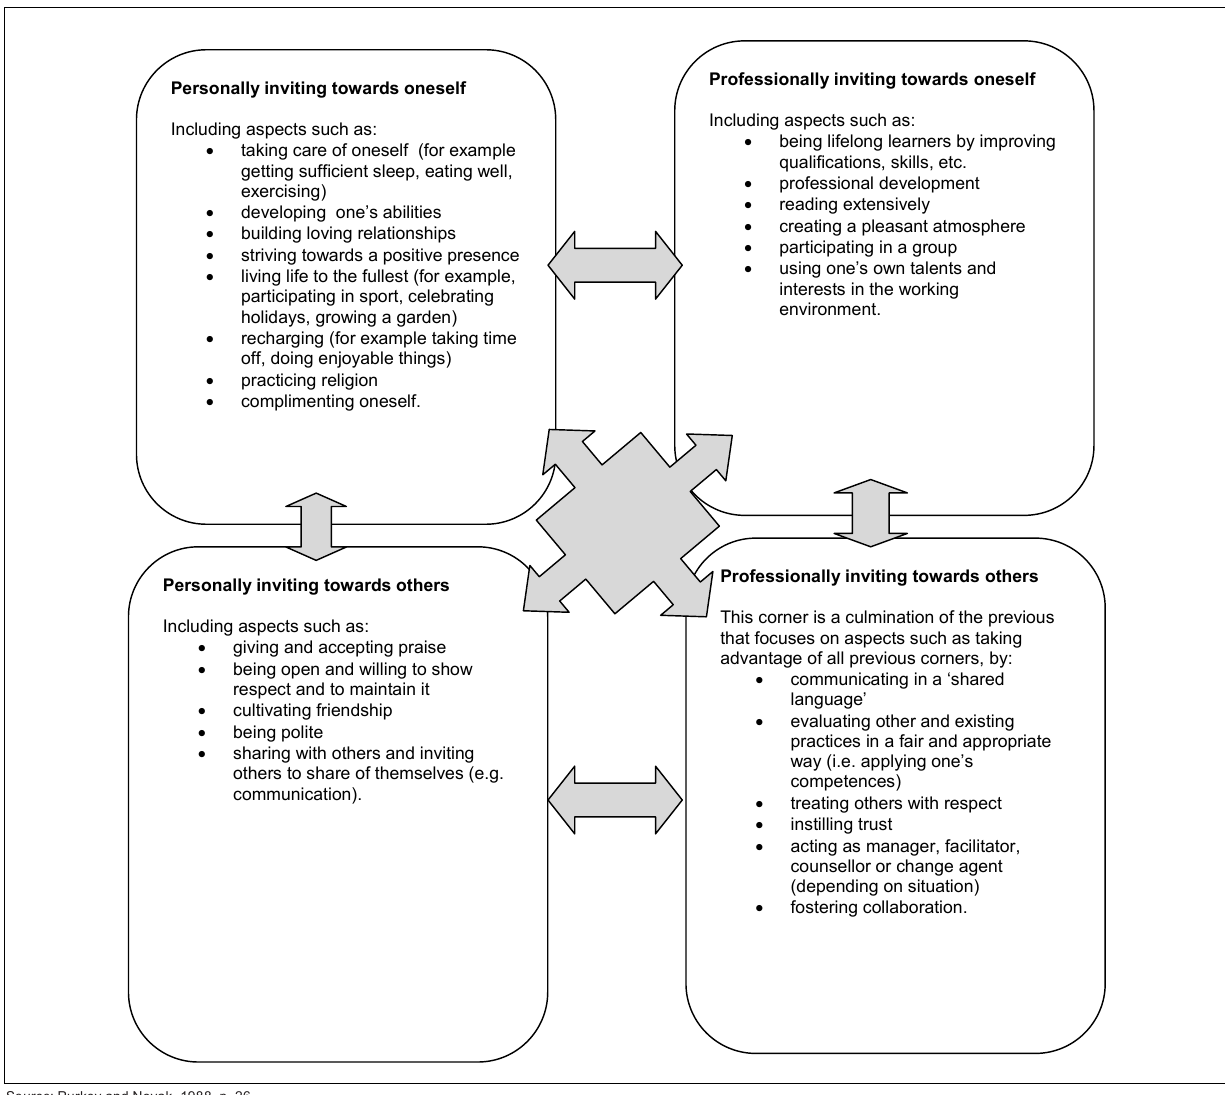
Figure 1 ‘Four Corner Press’ (A condensed